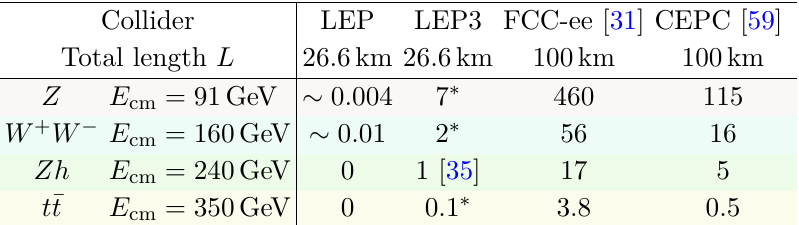
Table 1 . Expected luminosities in 10 34 cm − 2 s − 1 . The * stands for our estimate, based on rescalings from available